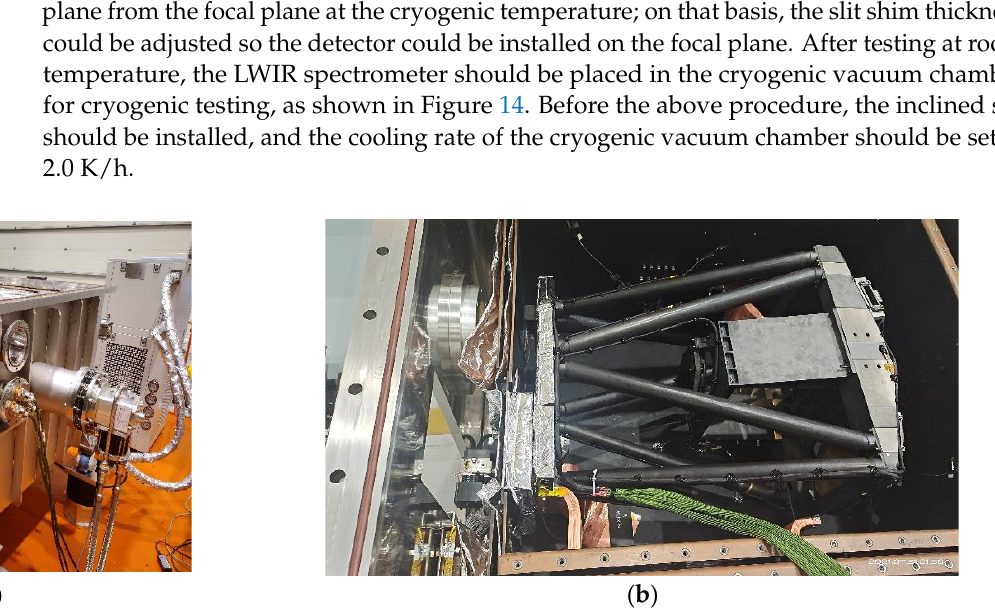
Figure 13. Layout of the refocusing test system.